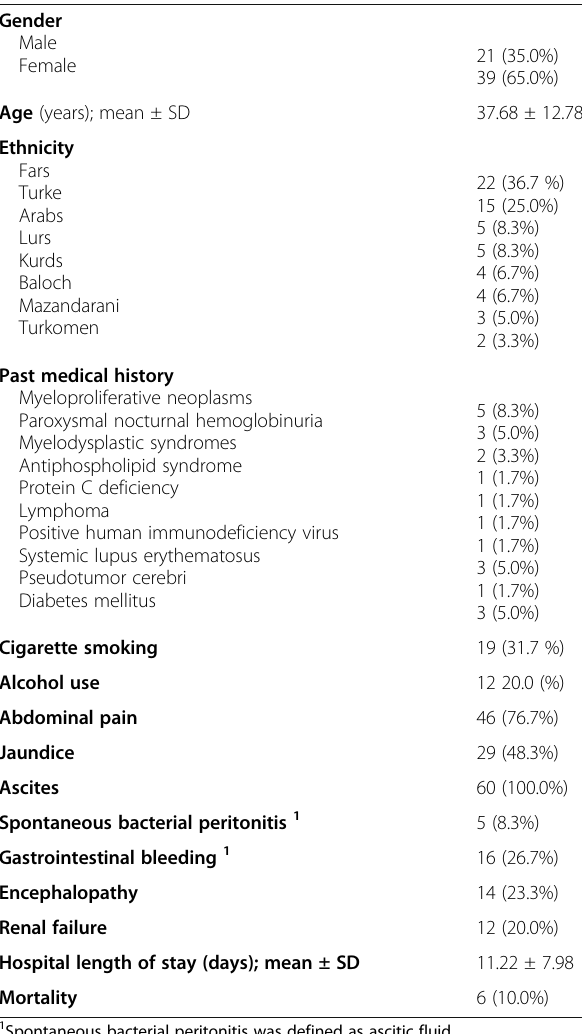
Table 1 Demographic and clinical characteristics of participants with Budd – Chiari syndrome ( n =